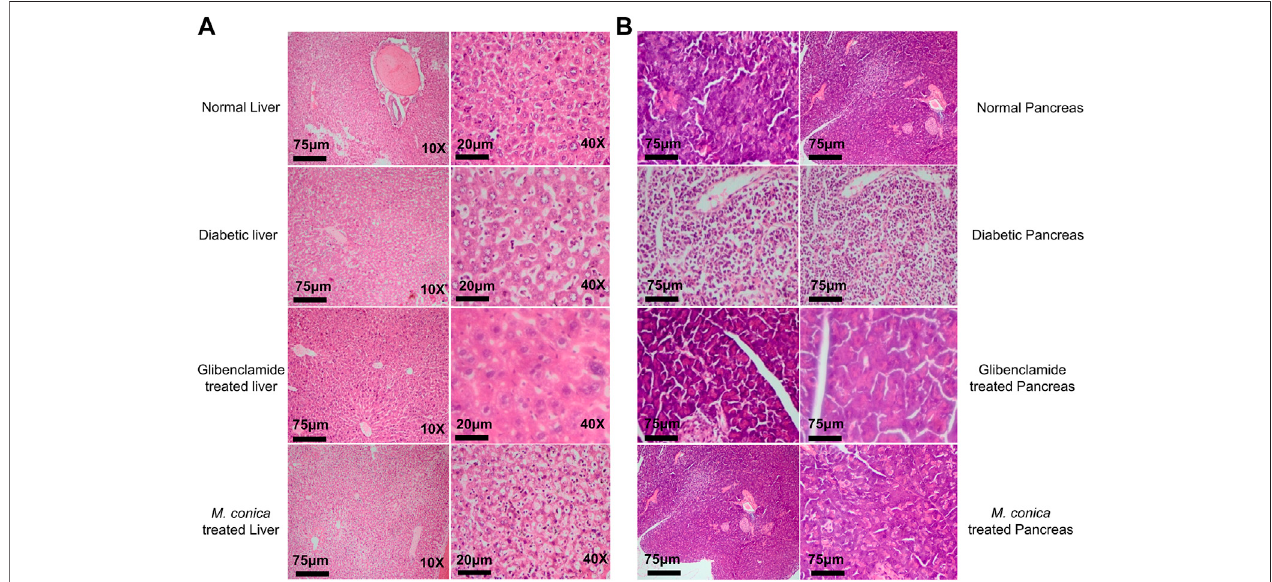
FIGURE 3 | (A) M. conica restored the morphological integrity of the liver, as shown by histological examination. Liver tissue was stained with H and E (magni fi cation,10 × scalebar75 μ mand40 × scalebar20 μ m). (B) M.conica restoredthemorphologicalintegrityofthepancreas,asshownbyhistologicalexamination.